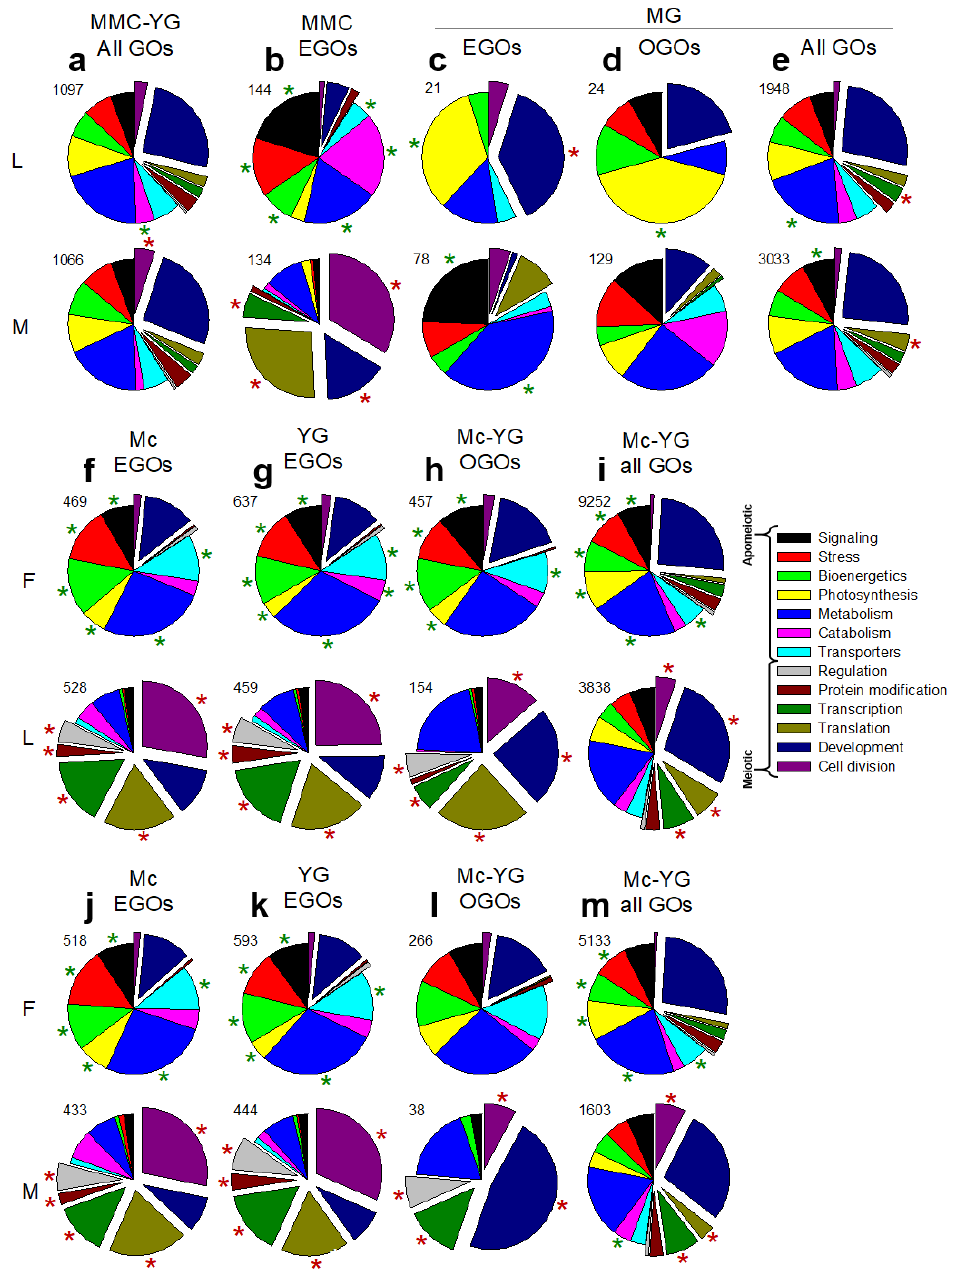
Figure 2. Pie charts of enriched gene ontology categories (EGOs), overexpressed GOs (OGOs), and GOs of di ff erentially expressed genes (all GOs) by GO group and by comparison: ( a – e ), L vs. M; ( f – i ), F vs. L; ( j – m ), F vs. M. F ( Boechera × formosa ), L ( Boechera lignifera ), M ( Boechera microphylla ), MMC (megasporocyte stage), Mc (meiocyte stage), YG (young gametophyte stage), MG (mature gametophyte stage). Normal and exploded sections tended to be more frequently observed in less and more meiotic taxa, respectively. Starred GO groups di ff ered significantly in frequency ( p ≤ 0.05): green stars, normal; red stars, exploded; values next to pies are total numbers of GOs observed.